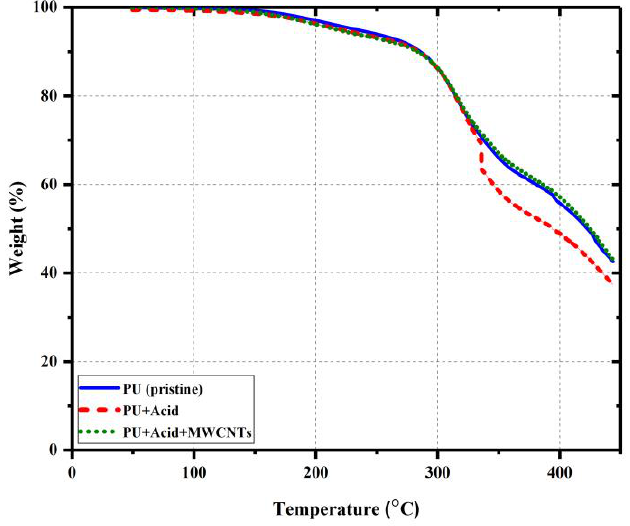
Figure 15. Thermogravimetric analysis (TGA) analysis of polymer specimens.